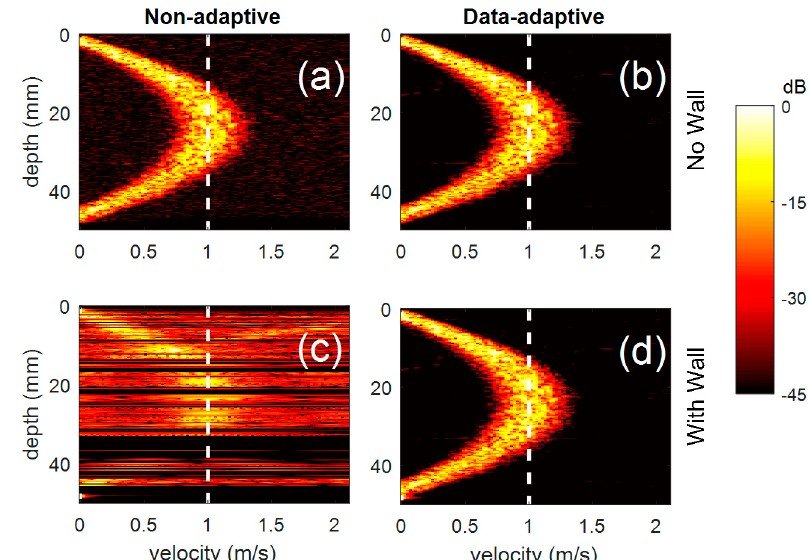
Figure 9. Power spectral matrices obtained for a simulated parabolic flow with 1 m/s peak velocity in a 45 mm diameter pipe. In ( c , d ) the signal from a static pipe-wall is added with a power 35 dB higher than the flow signal; in ( a , b ) the only flow signal is present. ( a , c ) are obtained with non-adaptive demodulator; ( b , d ) with data-adaptive demodulator. Horizontal axes report the Doppler shift converted to velocity. Vertical dashed lines correspond to the simulated peak velocity.